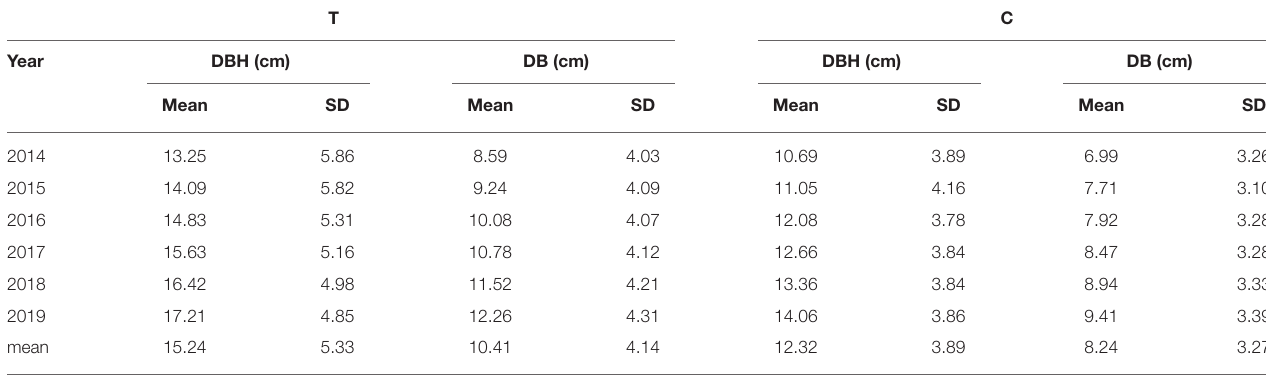
TABLE 1 | Forest structure metrics (means and standard deviations) in control (C) and treatment (T) for the period between 2014 and 2019. T